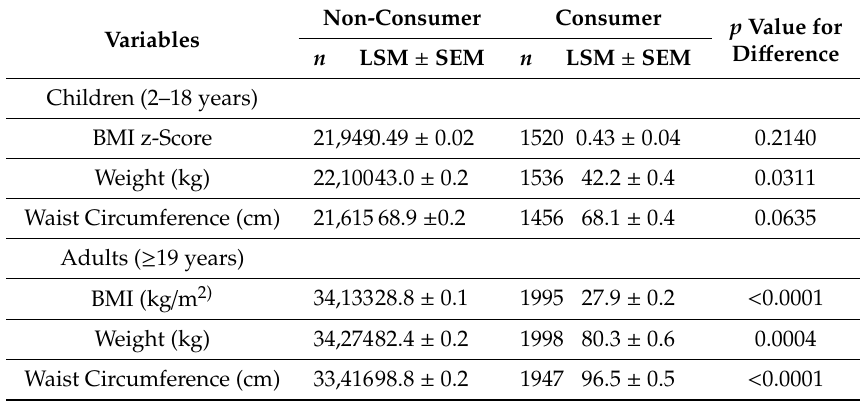
Table 5. Association of yogurt consumption with anthropometric measures in children and adults. (NHANES 2001–2016, gender combined data). Non-Consumer Consumer p Value Variables